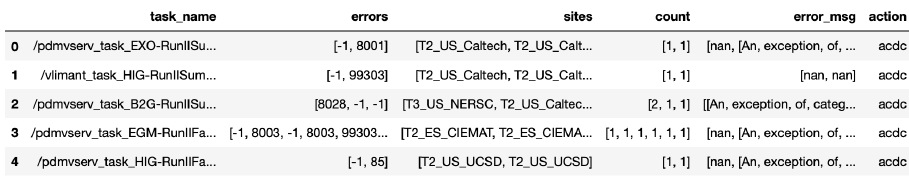
Figure 2: Pandas frame that contains the information to build the sparse error-site matrix and the labels for the Machine